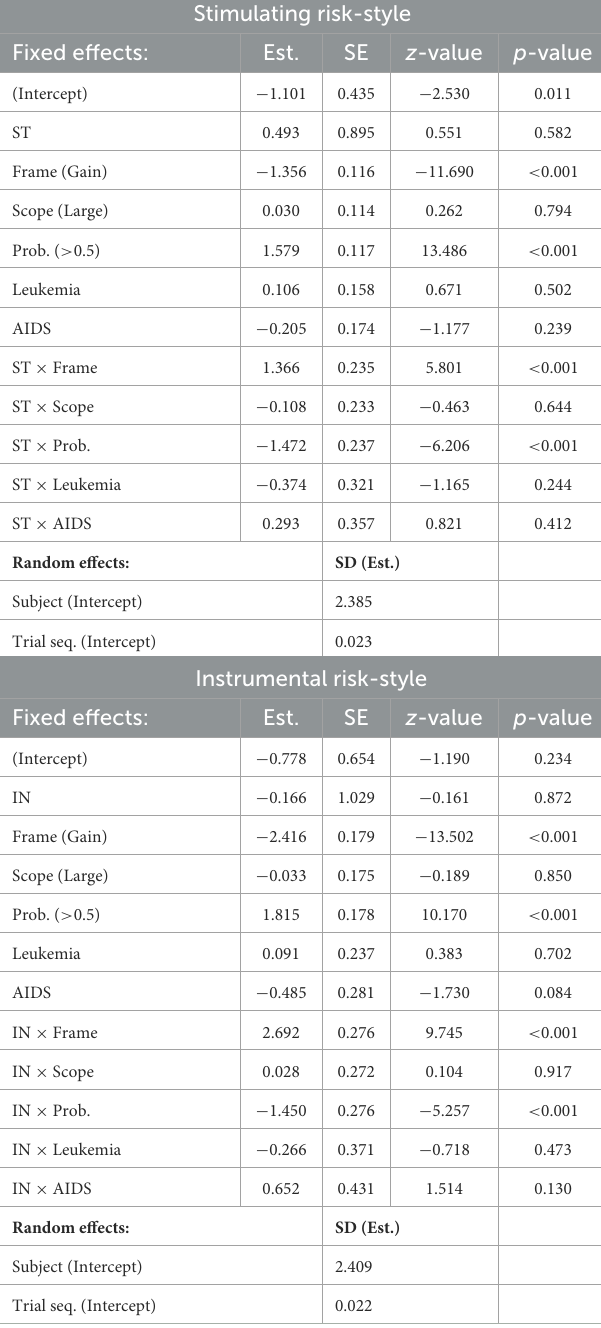
TABLE 9 Experiment 2: Generalized linear mixed models, Interactions: stimulating and instrumental risk-style. Stimulating